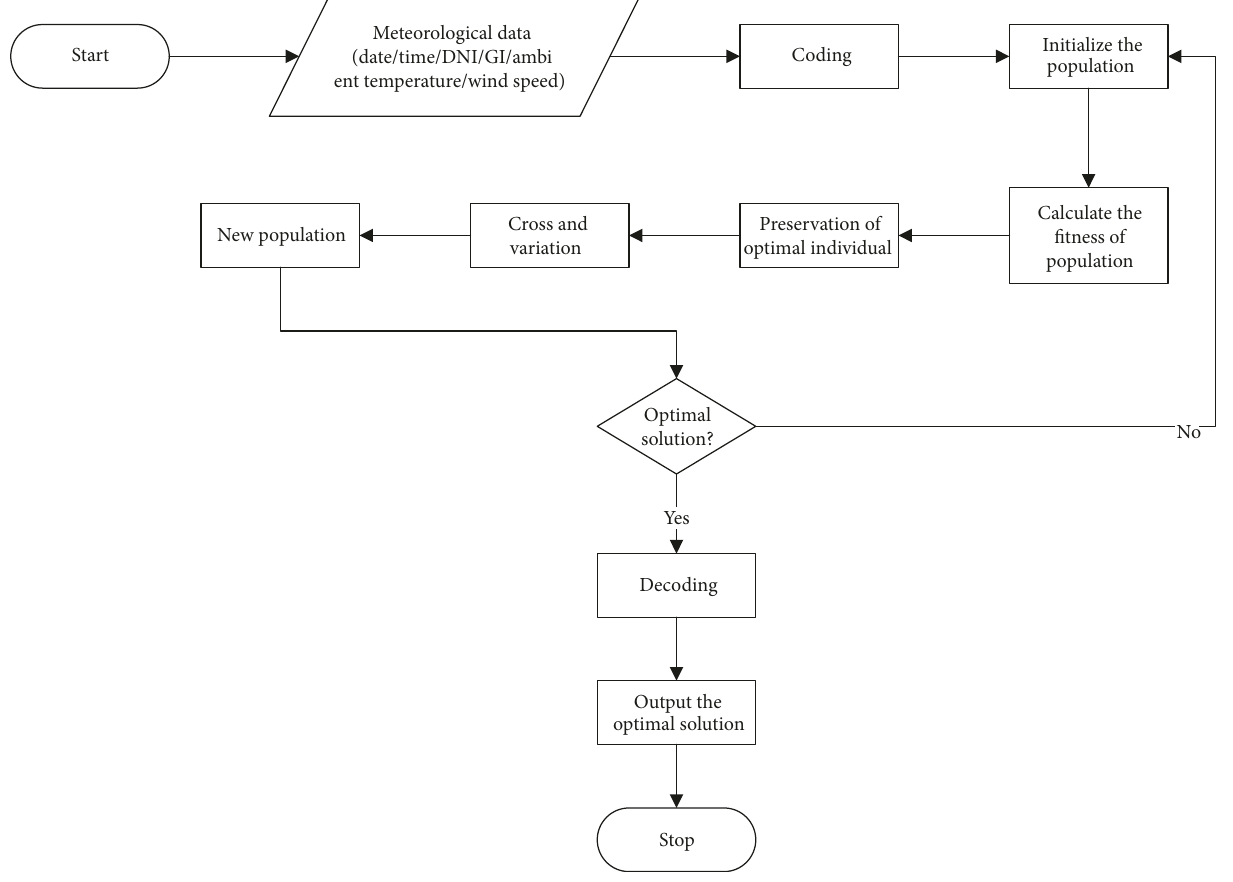
Figure 4: Process of genetic